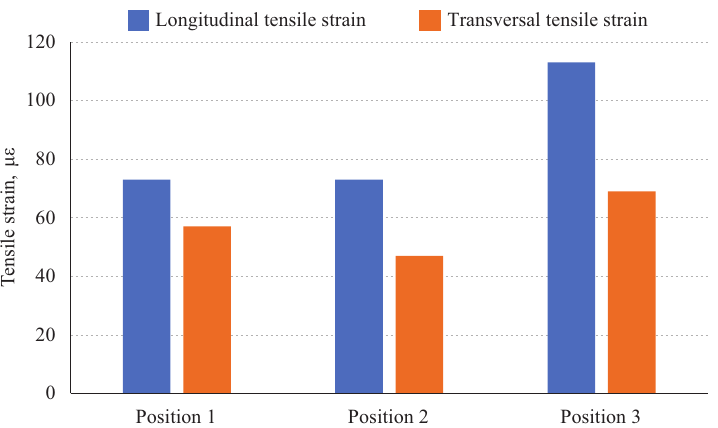
Figure 5. Tensile strain at the bottom of the asphalt concrete overlay versus axle load